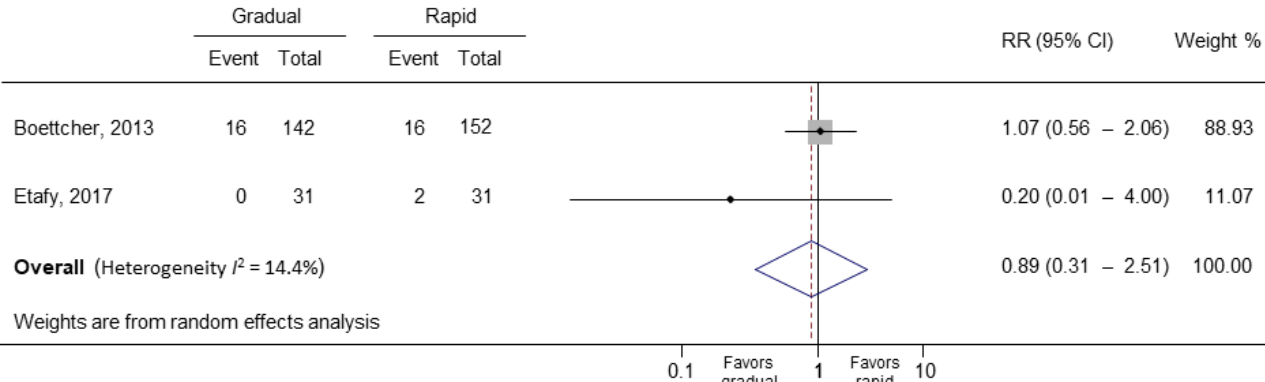
Figure 2. Forest plot of hematuria in gradual and rapid decompression groups. RR, relative risk; CI, confidence interval.